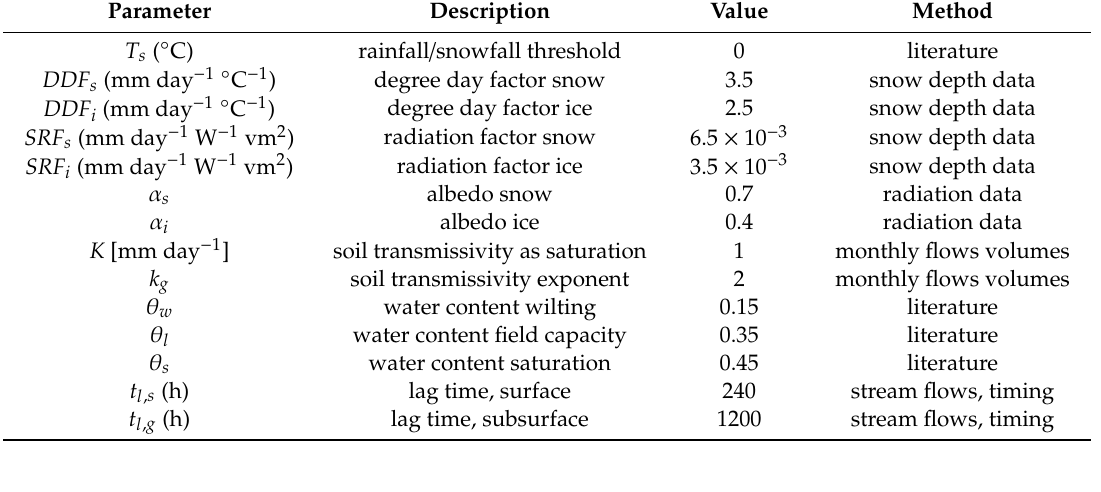
Table 2. Poli-Hydro model parameters, and corresponding values. In bold , calibration parameters.